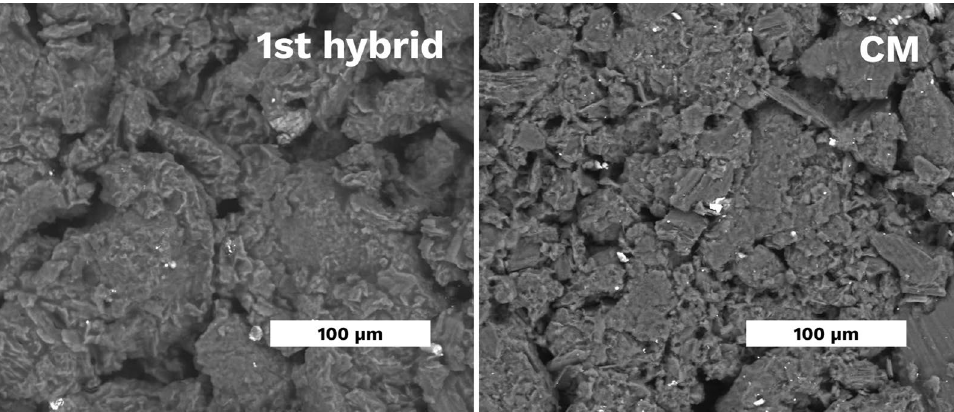
Figure 6. SEM images of the 1st hybrid sample (1 h-CIP-5) and CM compaction moulded sample.